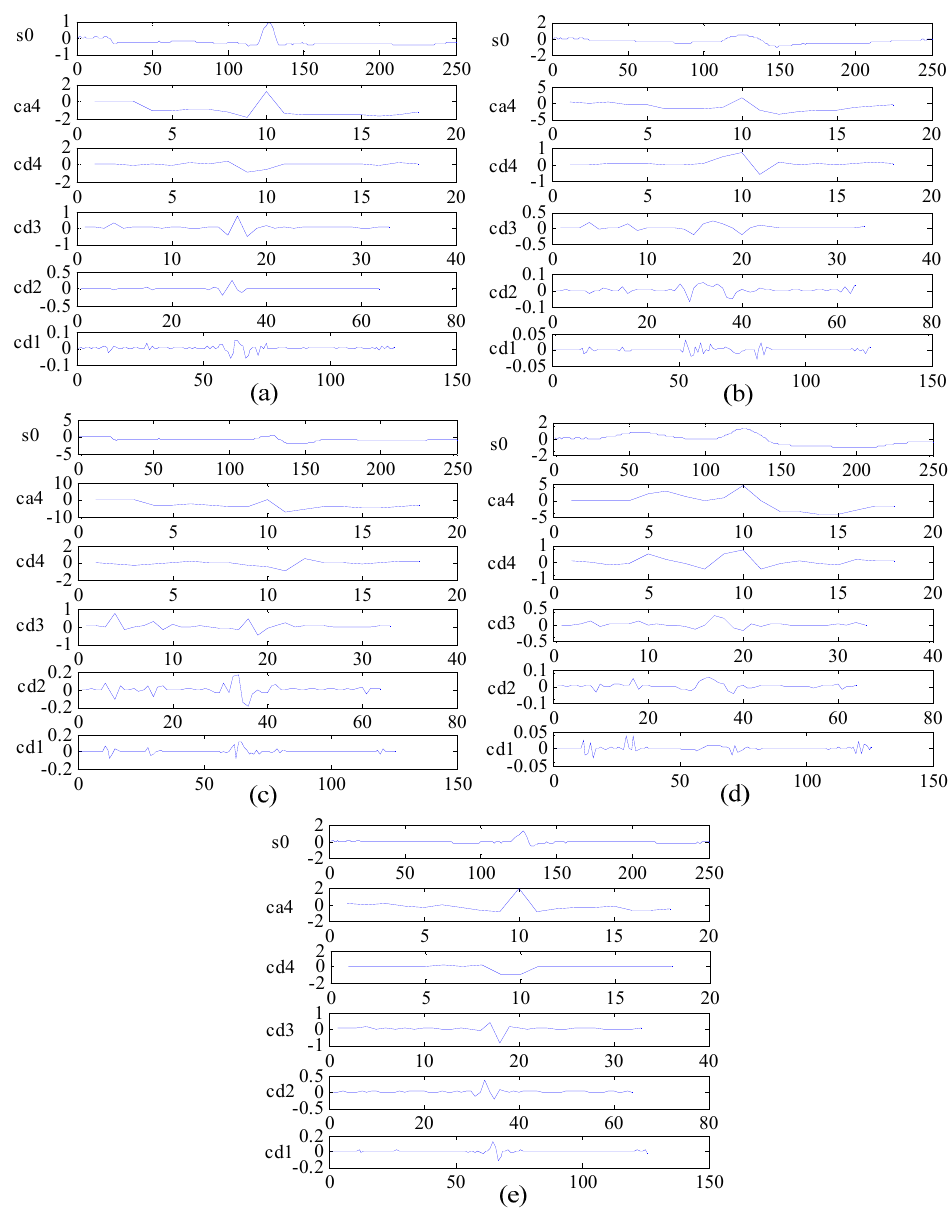
Figure 6. Frequency domain features of five types of ECG beats obtained through DWT. s0 is the original ECG beat, ca4 is the approximation of the 4th level and cd1 to cd4 are the details of each level. ( a ) ECG of record 100 is used to represent N; ( b ) ECG of record 109 represents LBBB; ( c ) ECG of record 118 represents RBBB; ( d ) ECG of record 106 represents PVC; and ( e ) ECG of record 209 represents APC.